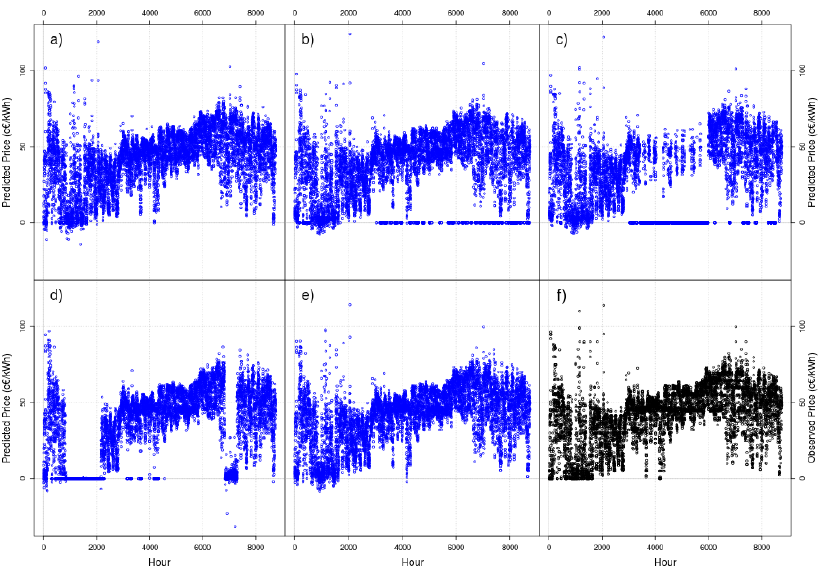
Figure 5. As blue points, one-hour ahead forecasts of DT with linear model for a moving window of 10 days. ( a ) Full model, ( b ) retire the oldest data, ( c ) retire the data discarded by active learning, ( d ) retire the oldest data and rejuvenate the particle set and ( e ) retire the data discarded by active learning and rejuvenate the particle set. As black points, ( f ) the 2014 real data to forecast.